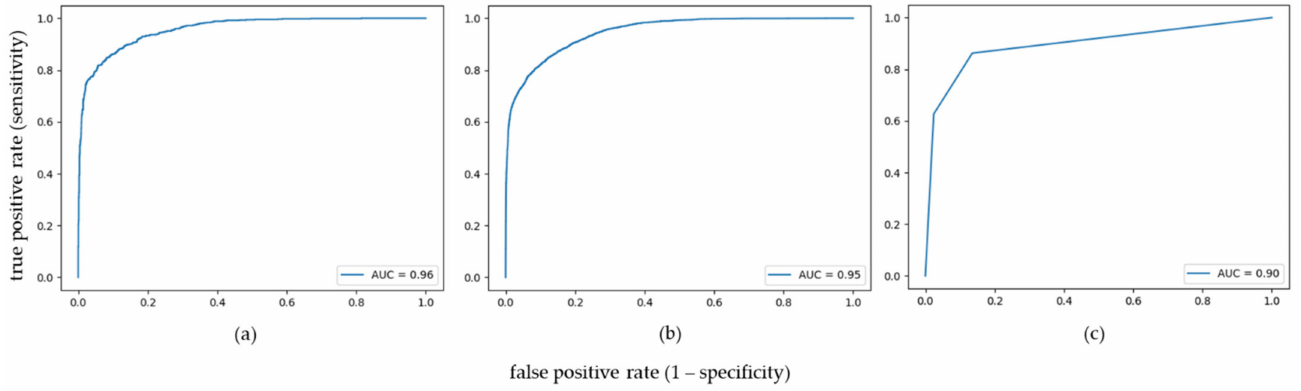
Figure 2. ROC curves for the binary classification task of differentiating between pancreatic ductal adenocarcinoma and cholangiocarcinoma using ( a ) support vector machine, ( b ) gradient boosting, and ( c ) k-nearest neighbors.